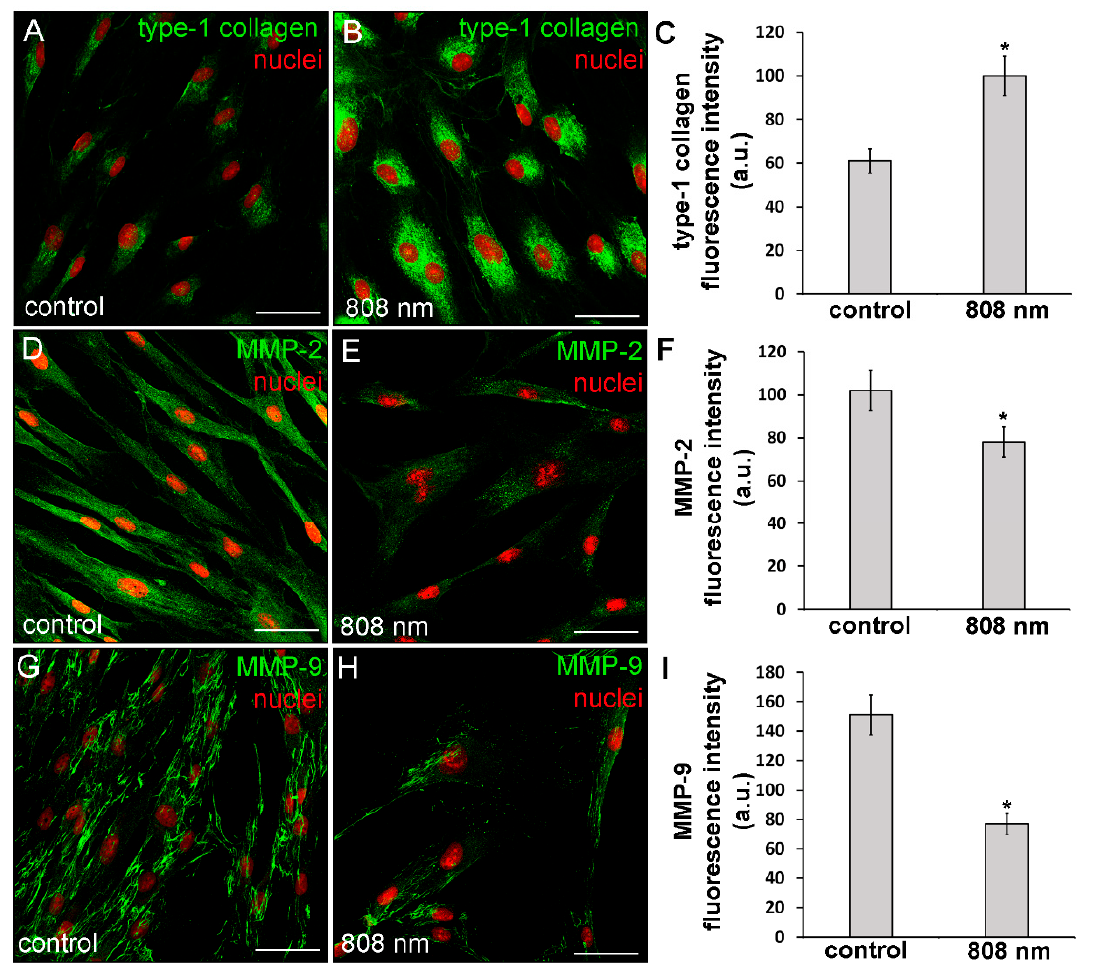
Figure 7. Confocal immunofluorescence analysis of the expression of type-1 collagen, MMP-2 and MMP-9 in HDF- α fibroblasts 24 h (MMPs) or 5 days (type-1 collagen) after exposure to NIR (808 nm) PBM. Cells not subjected to PBM treatments served as control. ( A , B , D , E , G , H ) Representative confocal fluorescence micrographs of fixed cells immunostained for detection of ( A , B ) type-1 collagen, ( D , E ) MMP-2 and ( G , H ) MMP-9 (green). Nuclei are labeled in red with PI. Scale bar: 50 µ m. ( C , F , I ) Histograms showing the densitometric analysis of ( C ) type-1 collagen, ( F ) MMP-2 and ( I ) MMP-9 fluorescence intensity performed on digitized images. Significance of difference: * p < 0.01 vs. control.